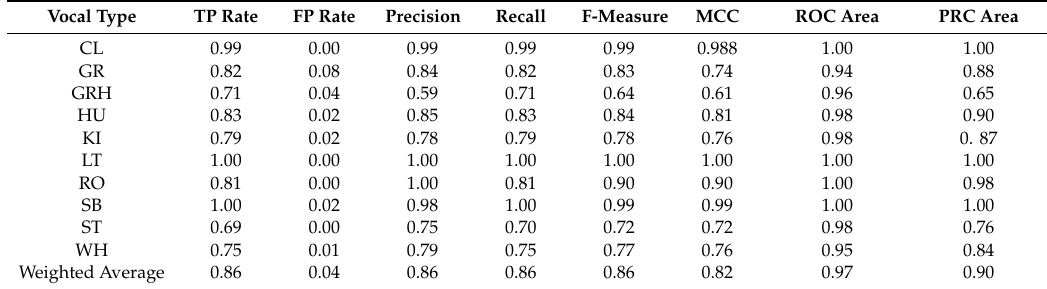
Table 2. Vocal type assignment detailed accuracy by class. TP rate: Rate of true positives; FP rate: Rate of false positives; precision: Proportion of instances that are truly of a class divided by the total instances classified as that class; F-measure: Combined measure for precision and recall; ROC area: Receiver operating characteristics measurement area; PRC area: Precision recall area.